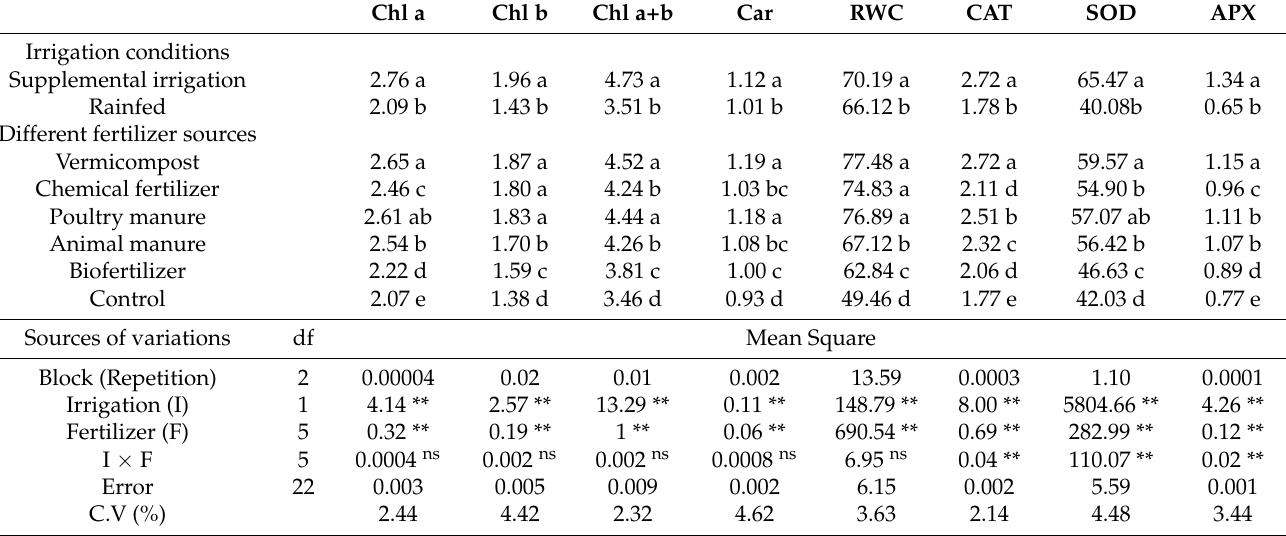
values were found under rainfed conditions in the biofertilized and control plants (Figure 2). Table 1. Analysis of variance and comparison of means of physiological traits and antioxidant enzyme activity of dragon’s head plants in response to irrigation conditions (I), different fertilizer sources (F), and their interaction (I × F). Different letters in each column indicate significant differences according to Tukey’s HSD test ( p < 0.05). Chl a Chl b Chl a+b Car RWC CAT